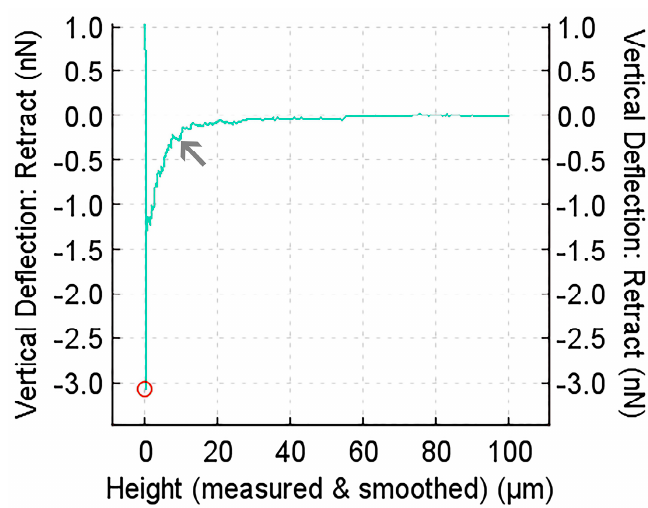
Figure 5. Force-displacement (FD) curve of a single osteoblast attached to PCL-coated dish surface for 180 s. The curve shows the maximum detachment force (red circle) of the cell and single cell-PCL surface bindings that were separated by moving the cell away from the PCL surface (small force steps, arrow).